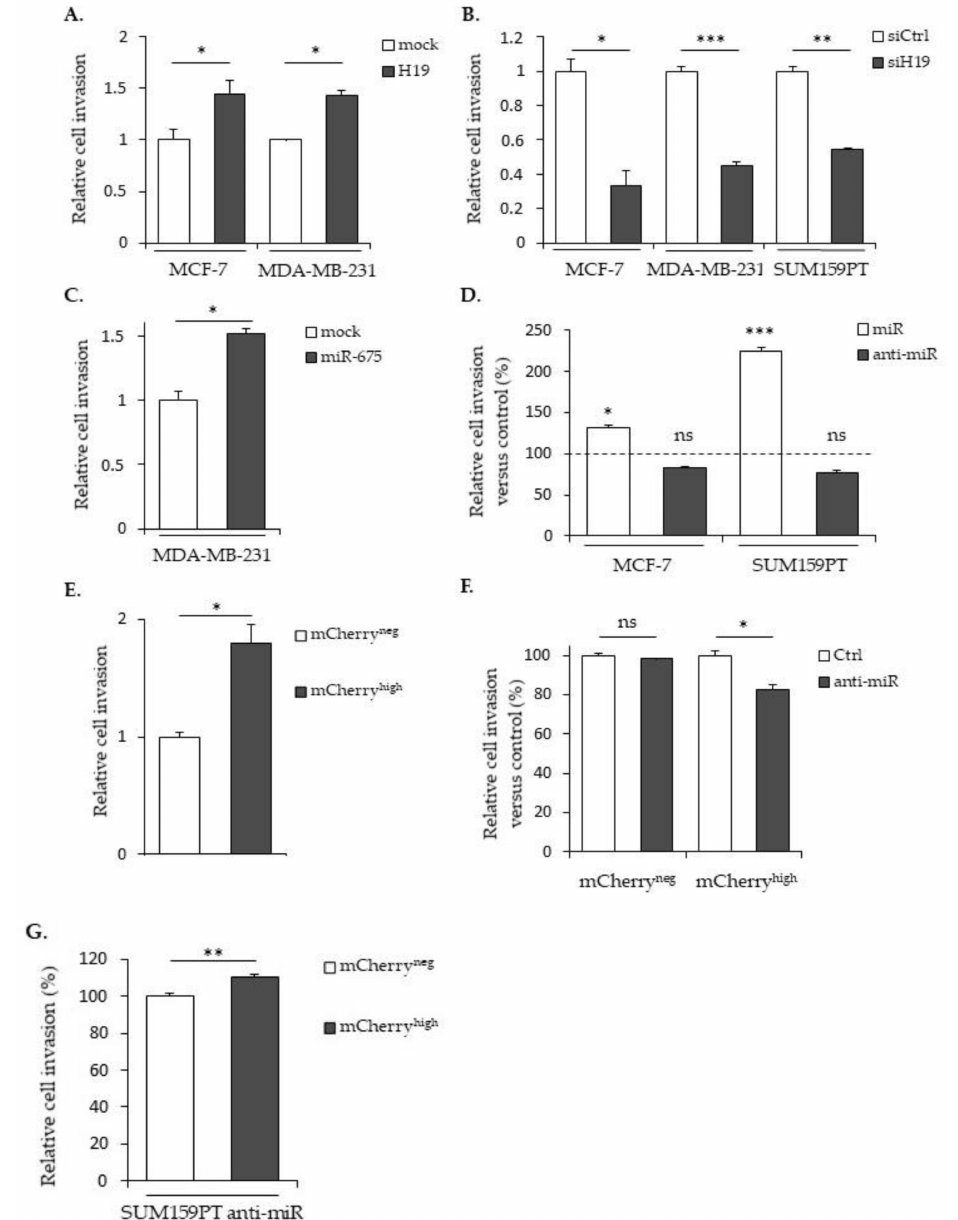
Figure 3. H19 and miR-675 participate in the breast cancer cells invasion. ( A ) Control (mock) or H19 -stably overexpressing cells (H19) were cultured in Transwell for 24 h. Invasive cells were then incubated with 1-mM Hoescht 33258 and counted. ( B ) Invasive capacities of the control (siCtrl) and H19 -knockdowned cells (siH19) determined by Transwell assay. ( C) MDA-MB-231 control (mock) or miR-675-stably overexpressing cells (miR-675) were cultured in Transwell for 24 h. Invasive cells were then incubated with 1-mM Hoescht 33258 and counted. ( D ) Invasive capacities of miR-675-transfected cells (miR) or miR-675-specific inhibitor transfected cells (anti-miR) determined by Transwell assay. Results are presented as the percentage of the control. ( E ) Relative invasive capacities of SUM159PT-pH19-mCherry neg versus SUM159PT-pH19-mCherry high determined by Transwell assay. ( F ) Invasive capacities of miR-675-specific inhibitor transfected cells (anti-miR). Results are presented as the percentage of the control. ( G ) Invasive capacities of miR-675-specific inhibitor transfected cells (anti-miR). Results are presented as a percentage of the mCherry neg condition. * p < 0.05; ** p < 0.01; *** p < 0.001; ns: not